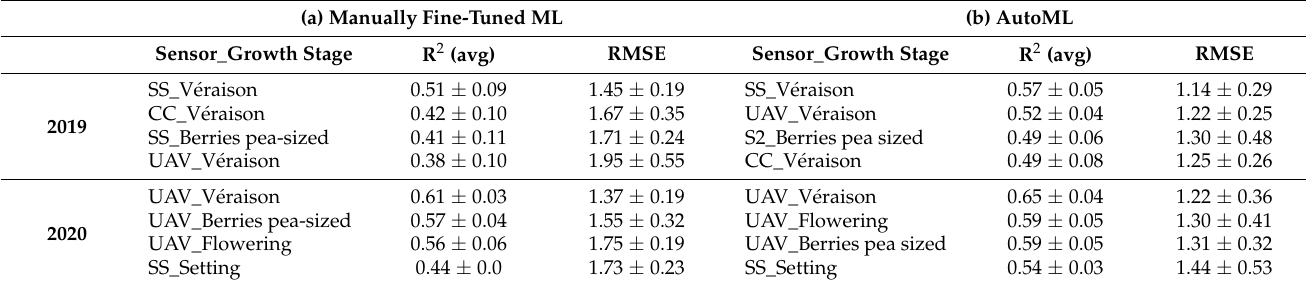
Table 2. Comparison of selected best R2 values with (a) Manually fine-tuned ML (adapted from Kasimati et al., 2021a) and (b) AutoML to evaluate their performance in assessing the wine grapes quality characteristics (CC, CropCircle; SS, Spectrosense + GPS; UAV; and S2, Sentinel-2).